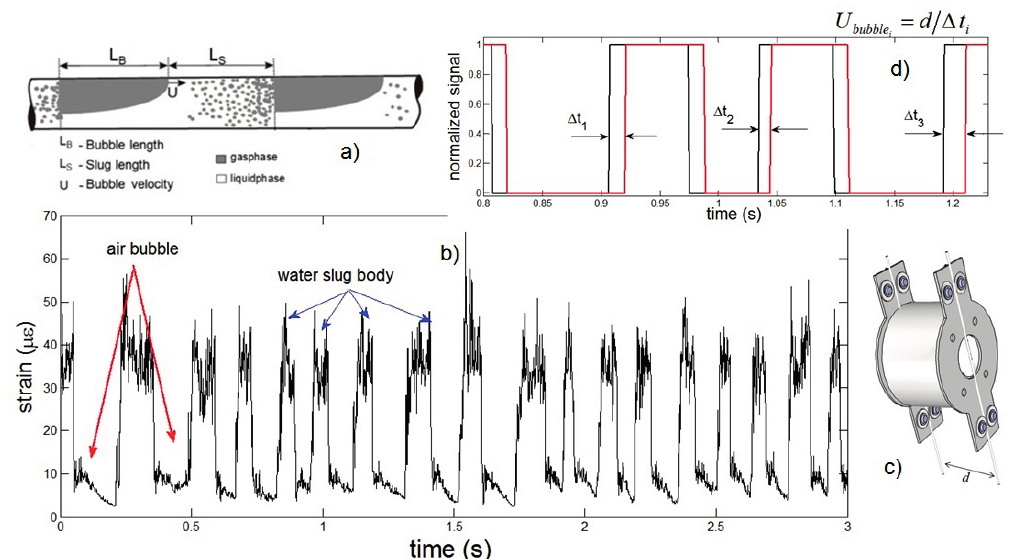
Figure 5. ( a ) Schematic representation of the slug flow with detailed information about the air bubble and liquid slug length and shape; ( b ) Example of a time series detected by the FBG for a typical slug flow for water and air velocities of 2 m/s; ( c ) Detail of the sensor assembly showing a pair of sensors and the fixed distance d = 5 cm between them; ( d ) Treated signal for two FBGs as in (c), indicating the time lag Δ t between the measured signals that is used to measure the bubble velocity.